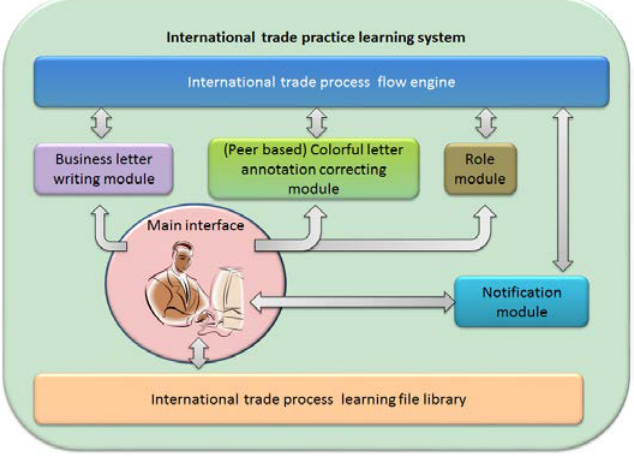
Figure 1 . International trade practice learning